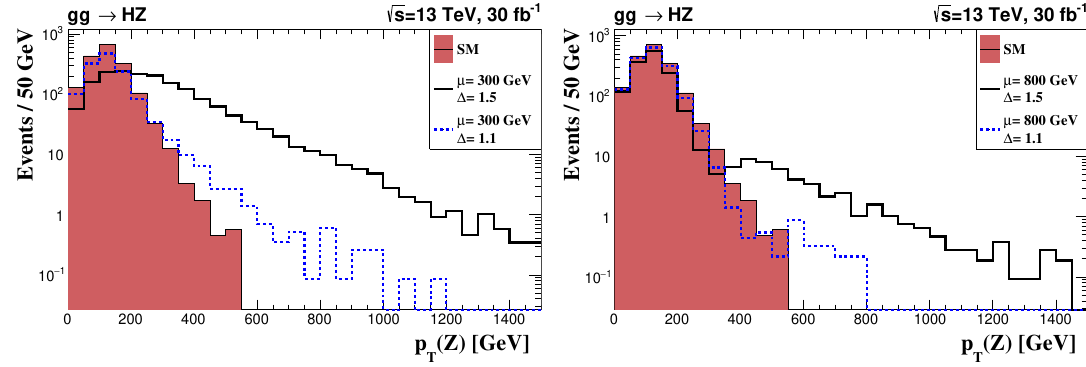
Figure 20. gg ! HZ , versus the Z boson p T ( Z